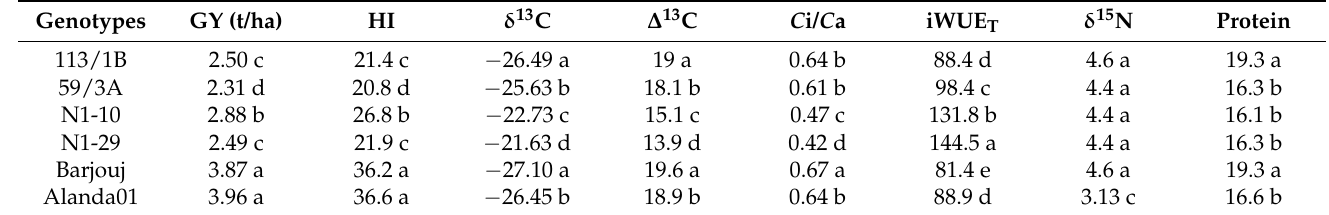
Table 8. Genotype and treatment effects on seed yield, harvest index, carbon and nitrogen isotope attributes of six barley genotypes grown under different water salinity